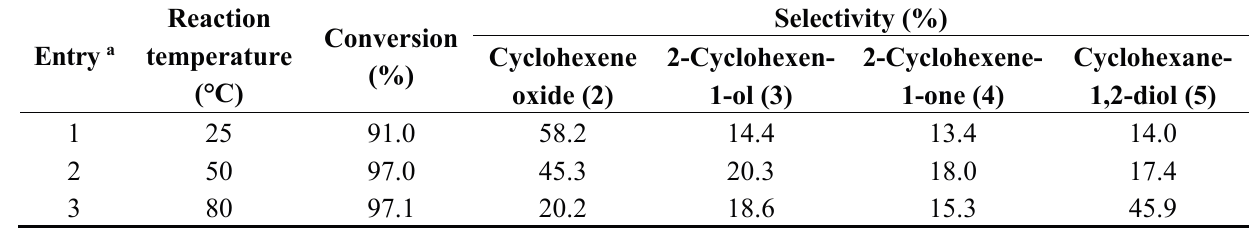
Table 3. The selective oxidation of cyclohexene to 1,2-diols catalyzed by iron (III) phthalocyanines with triflate as a counter anion by using H 2 O 2 as an oxidant at different